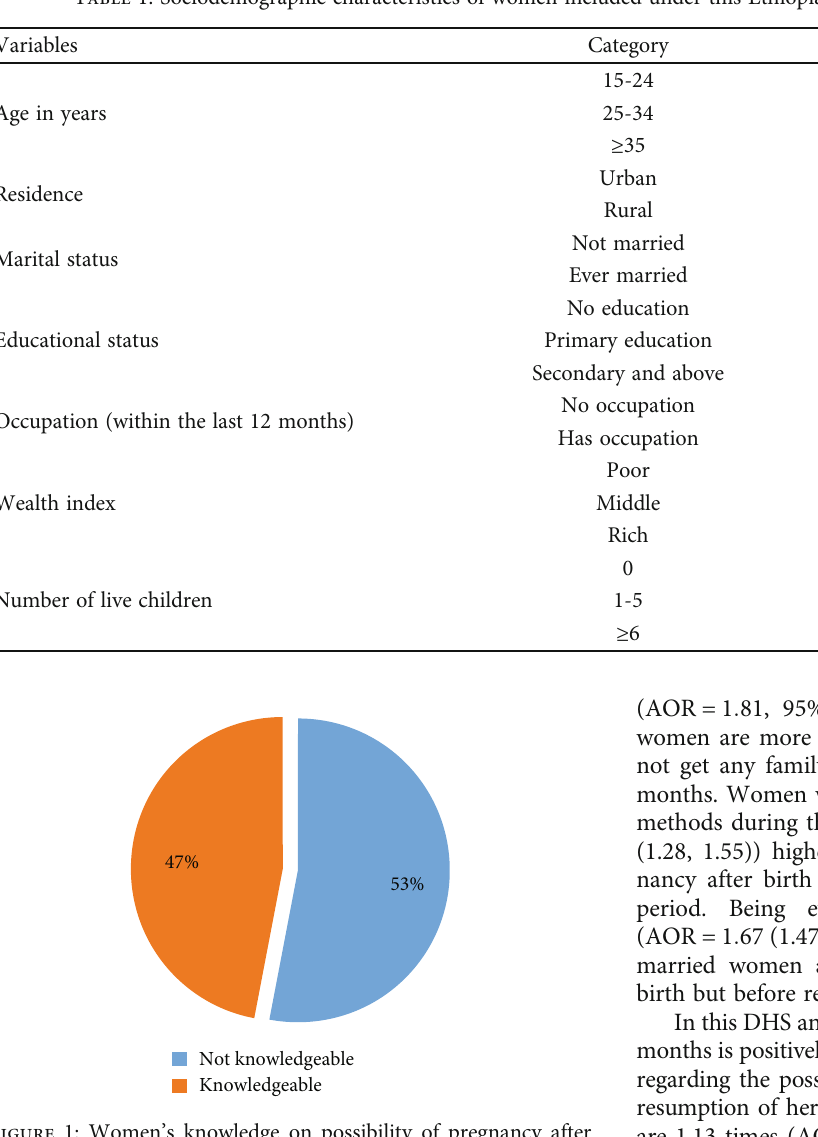
Table 1: Sociodemographic characteristics of women included under this Ethiopian demographic health analysis